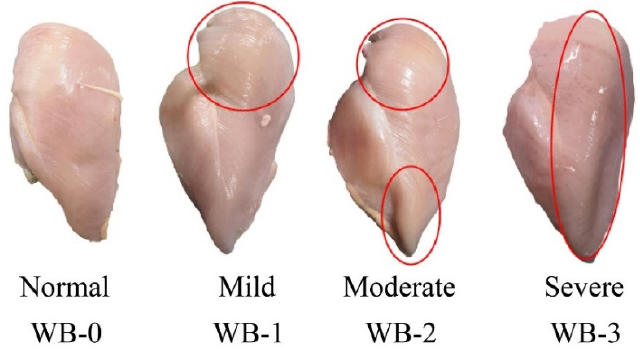
Figure 3. Wooden breast (WB) scoring scale based on tactile assessment where score 0 = normal breast muscle which is flexible throughout; score 1 = mild breast muscle, which is hard mainly in the cranial region but flexible elsewhere; score 2 = moderate breast muscle, which is hard throughout but flexible in the mid to caudal region; score 3 = severe muscle, which is extremely hard and rigid from the cranial region to the caudal tip.